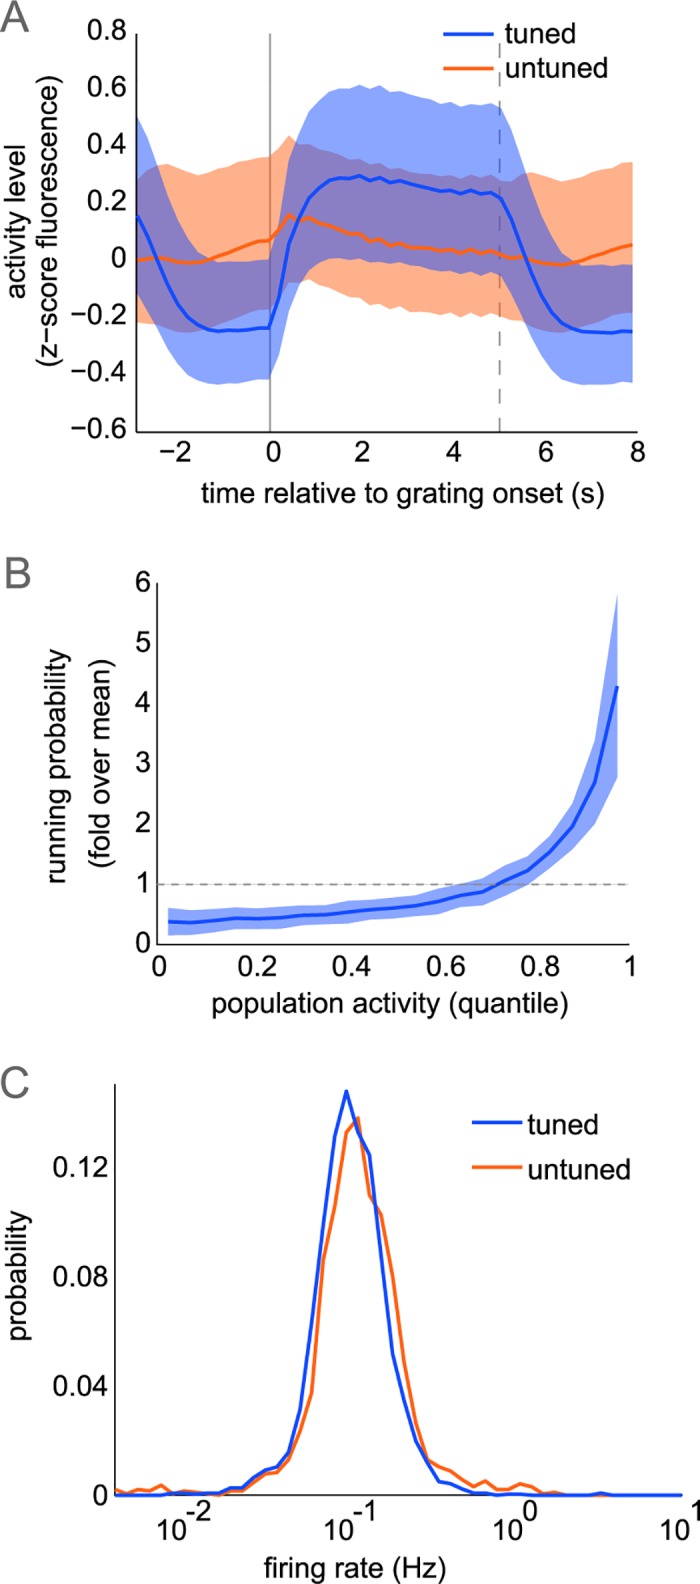
Population response properties.(A) Mean time-varying fluorescence of active neurons, pooled across datasets, during grating stimulus and preceding, following grey periods in tuned, untuned subpopulations (median+/-quartiles across pooled neurons). The 3-second grey period is shown before and after the grating response. Grating onset, offset shown in solid, dotted lines respectively. (B) Total population fluorescence split into equal quantiles to compute probability of running (speed>0.1cm/s). Plot shows mean+/-std across datasets (n = 23). (C) Inferred firing rate distributions computed across all imaging frames from spike trains inferred from fluorescence.